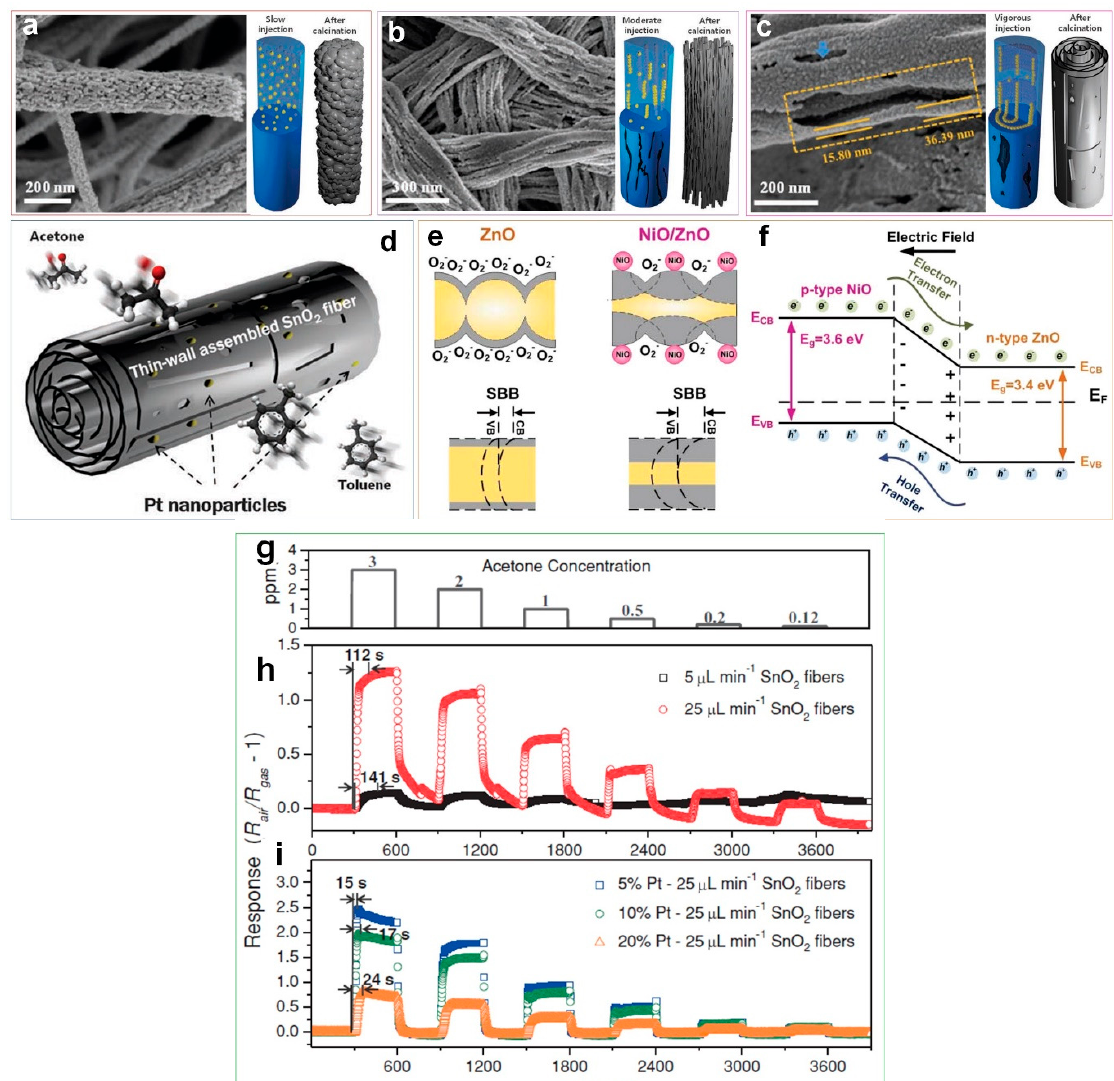
Figure 6. SEM images and schematic illustrations of morphological evolution of as-spun and calcined SnO 2 fibers prepared at ( a ) 5 µl ∙ min − 1 , ( b ) 15 µl ∙ min –1 and ( c ) 25 µl ∙ min − 1 flow rates, and ( d ) Pt-decorated thin-wall assembled SnO 2 fibers. [50] ( e ) Schematic of photodetection mechanism for pure ZnO and NiO/ZnO heterojunction device. The grey and yellow areas represent electron depleted and conducting regions, respectively. ( f ) Schematic of electron-hole separation in the NiO/ZnO heterojunction device. [39] ( g ) The cyclic acetone response of the sensor at different concentrations, with respect to time. The acetone response of ( h ) pure SnO 2 fibers with 5 and 25 µl ∙ min − 1 flow rate and ( i ) modified fibers with 5, 10 and 20 wt.% Pt decoration [50]. Reproduced with permission [50], Copyright 2013, Wiley Online Library. Reproduced with permission [39], Copyright 2017, RSC Publishing.